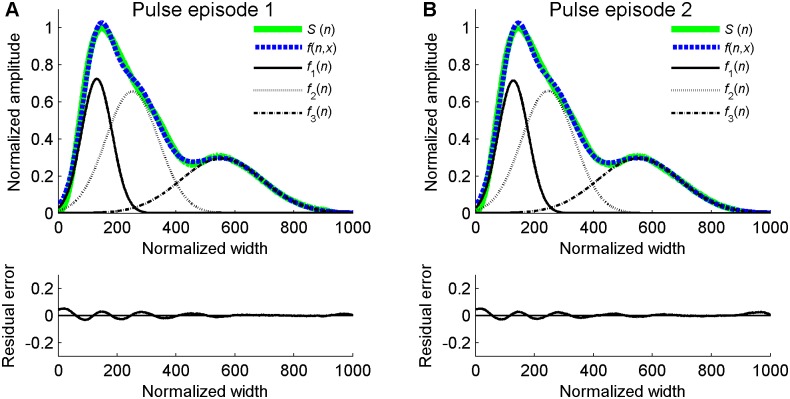
Examples of waveform fitting for the normalized pulse episodes.(A) Fitting results for the normalized pulse episode 1 in Figure 2 (B), (B) fitting results for the normalized pulse episode 2 in Figure 2 (C). In each sub-figure, the upper panel shows the original normalized pulse episode S(n), the fitting curve f(n,x) and the corresponding three Gaussian functions f
1(n), f
2(n) and f
3(n) from left to right in turn. The bottom panel shows the corresponding residual error of the waveforms fitting.